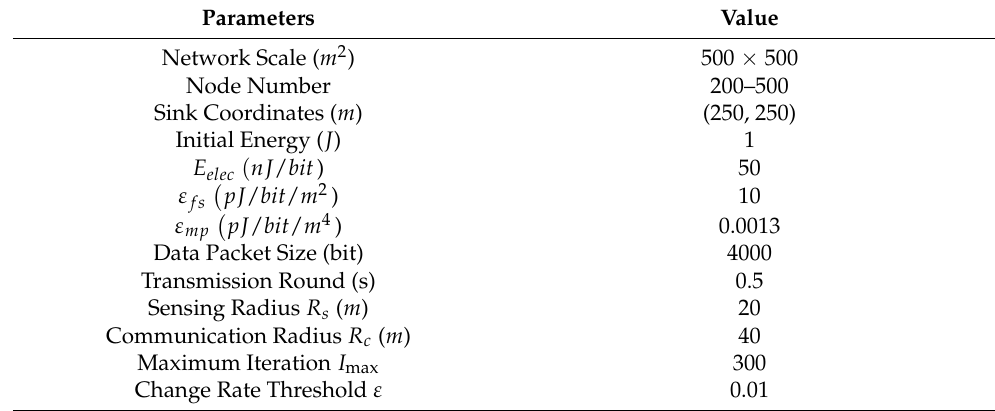
Table 1. Simulation